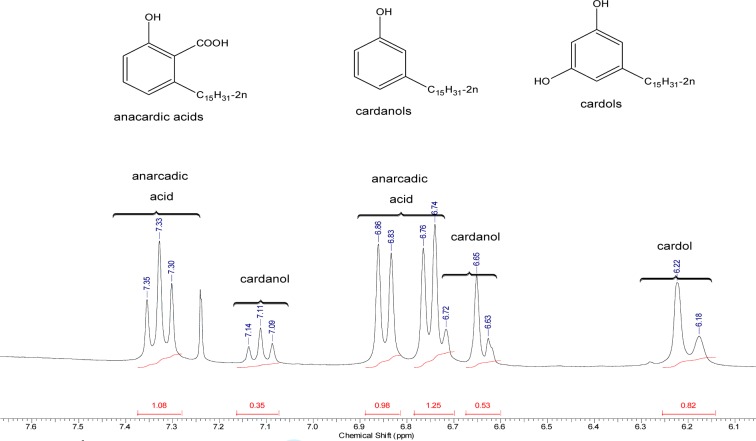
1H-NMR spectra of natural CNSL (expanded region for aromatic protons).